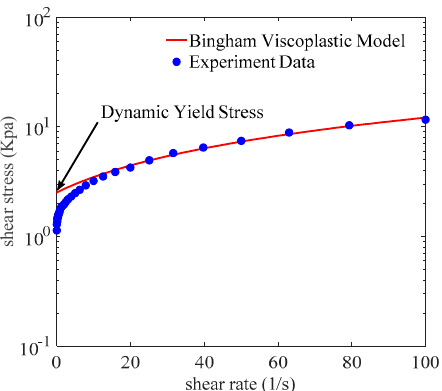
Figure 3. Calculation of dynamic yield stress of MR grease at zero shear rate